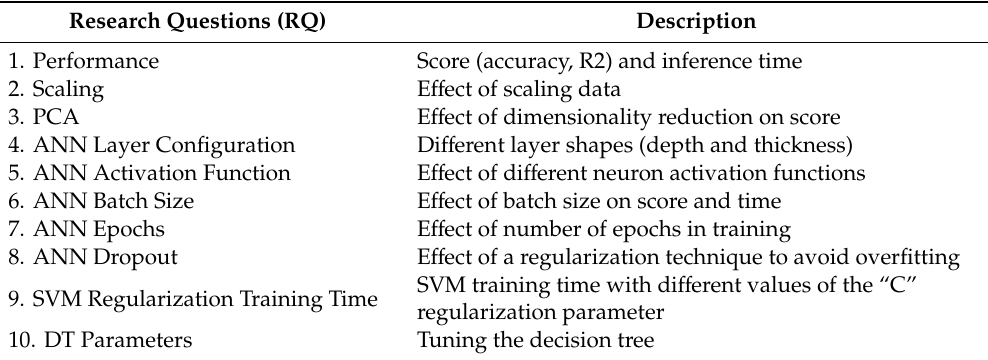
Table 5. Research